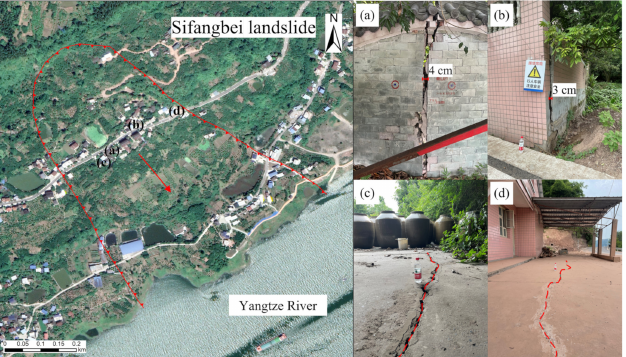
Figure 3. Deformations on the Sifangbei landslide: ( a ) About 4 cm of building wall cracked; ( b ) about 3 cm of building wall cracked; ( c ) a ground crack in the yard; and ( d ) a road crack on the east